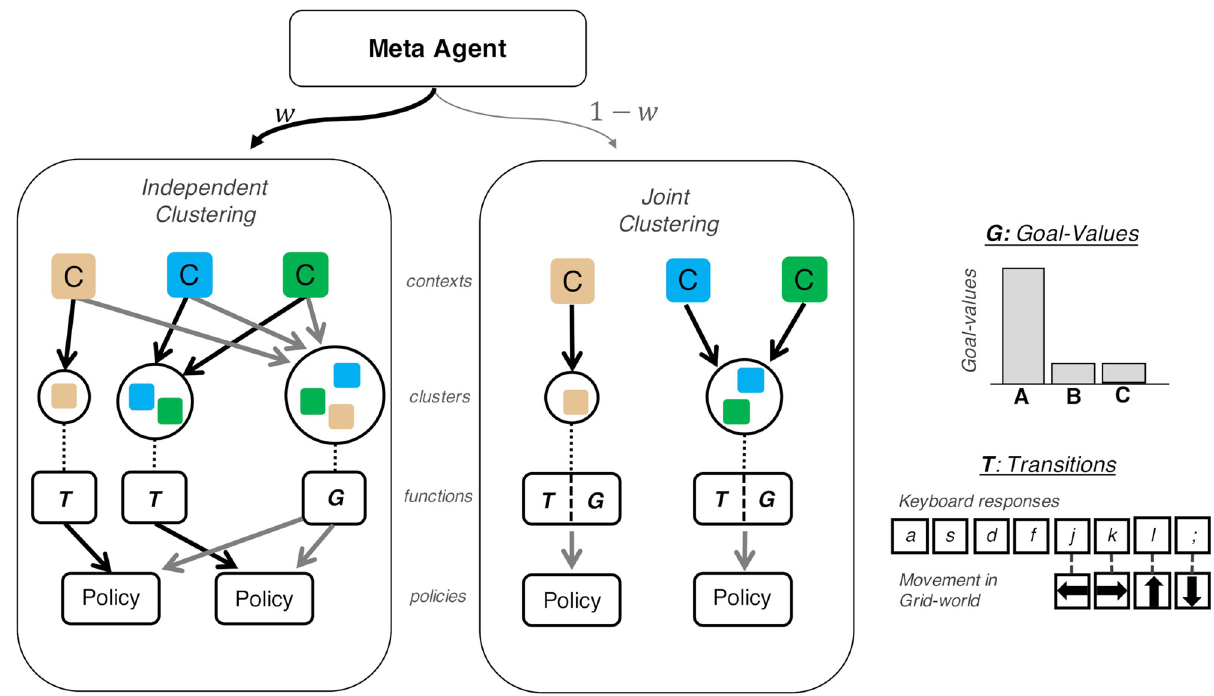
Fig 2. Schematic depiction of computational agent. The meta-generalization agent arbitrates between independent clustering and joint clustering according to a learned weight w . In both clustering strategies, contexts (colored squares) are grouped into clusters based on the statistics of their associated goal (G), and transition (T) functions. Independent clustering clusters each context twice, once each for goal-value and transition functions, whereas joint clustering assigns each context into a single cluster. Planning derives a behavioral policy from the learned contingencies. Adapted from